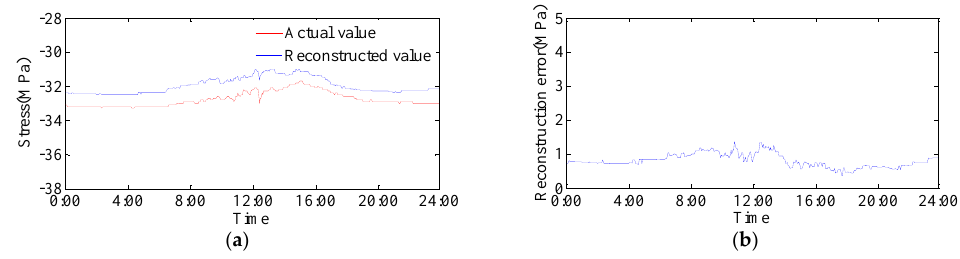
Figure 9. The reconstructed value and actual value using response variables X P 5 : ( a ) the curve of the reconstructed value and the actual value; and ( b ) the curve of reconstruction error.